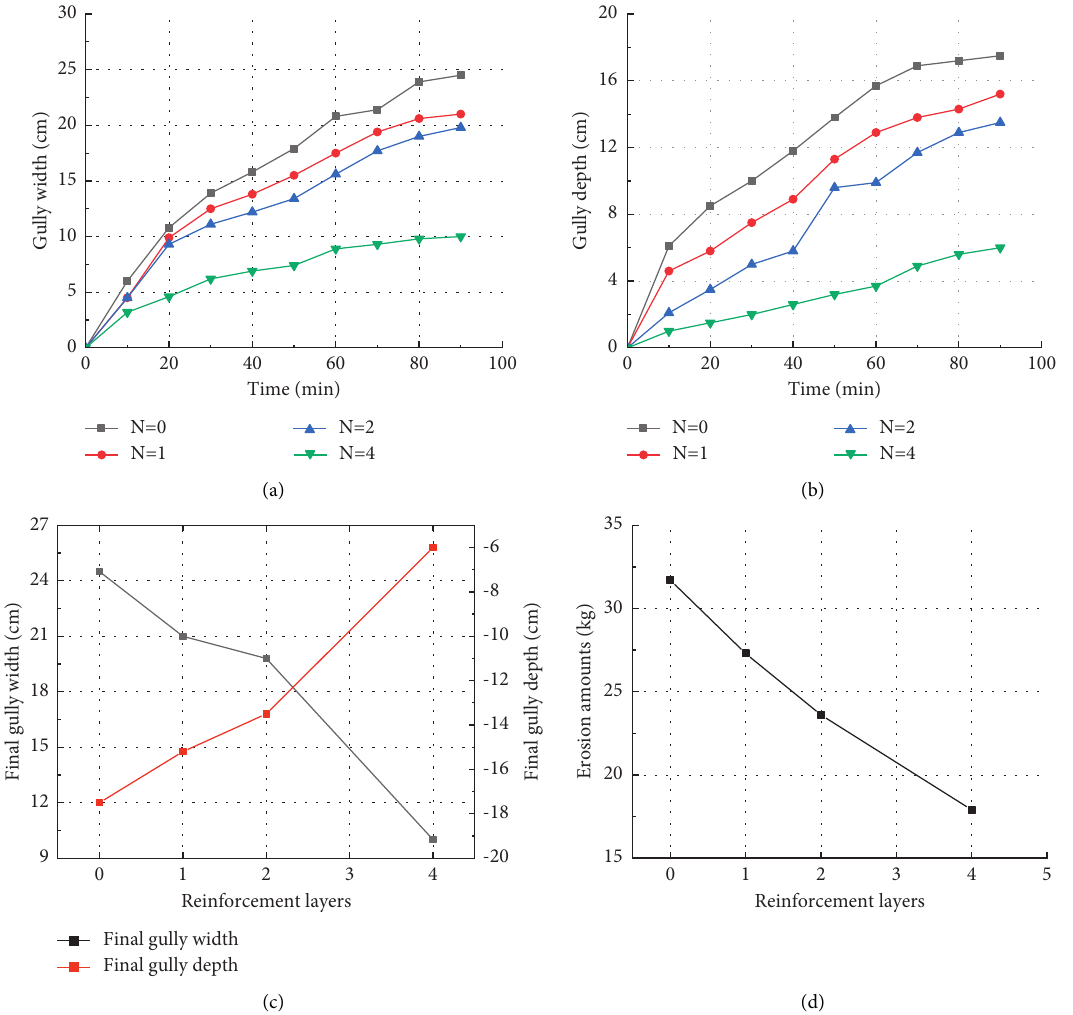
Figure 10: Erosion damage consequences of different reinforcement layers: (a) gully width changes with time; (b) gully depth changes with time; (c) final gully width and depth; (d) final erosion